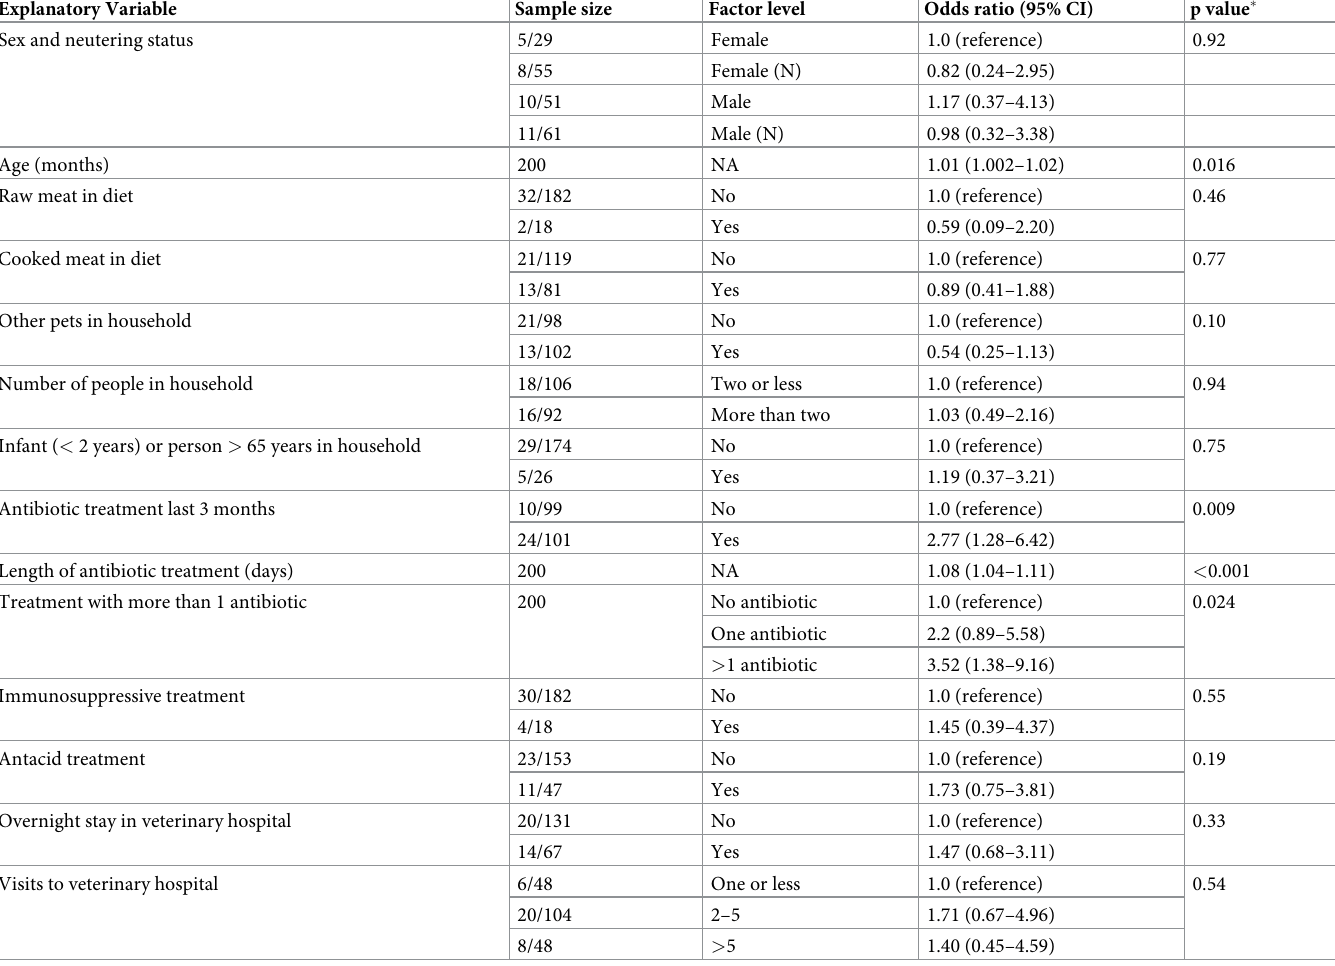
Table 1. Univariable analysis of risk factors potentially associated with the carriage of C . difficile in dogs presented to the University of Glasgow, Small Animal Hos- pital referral